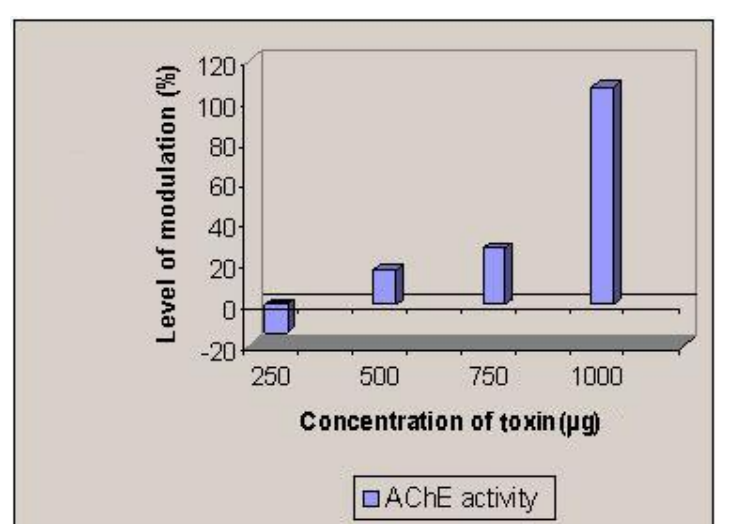
Figure 5. Modulation of AChE activity by the chloroform-methanol (2:1) extract of Halichondria panicea .